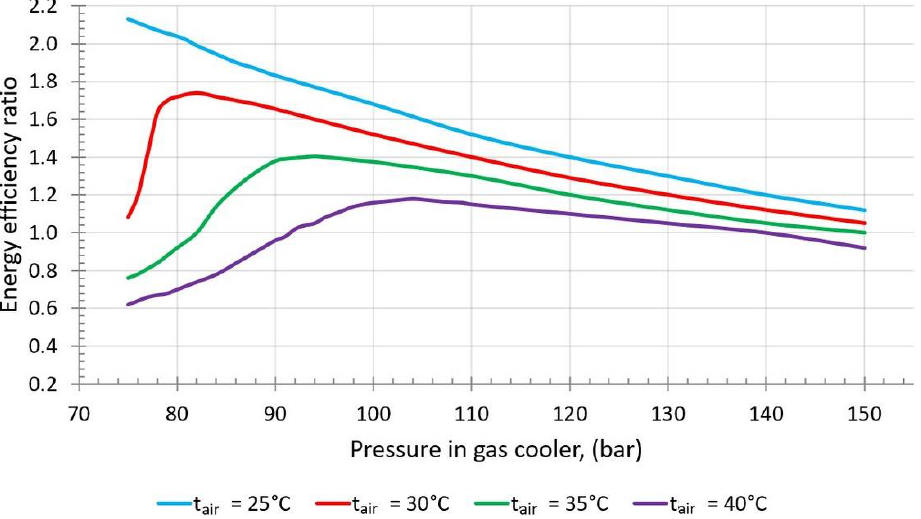
Figure 1. Variation of EER with pressure in the gas cooler and ambient air temperature for transcritical carbon dioxide cooling system, where t air is the temperature of ambient air [14].